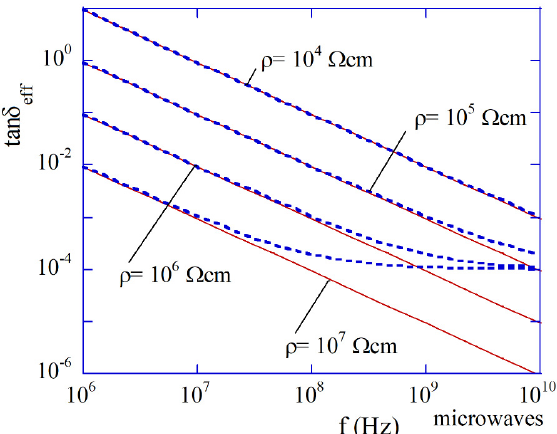
Figure 7. The effective loss tangents of high resistivity semiconductors as functions of frequency assuming dielectric polarization loss tangent term equal to 10 − 4 . Solid lines denote terms depending on pure conductor losses i.e., σ / ( ωε 0 ε (cid:48) r ) .